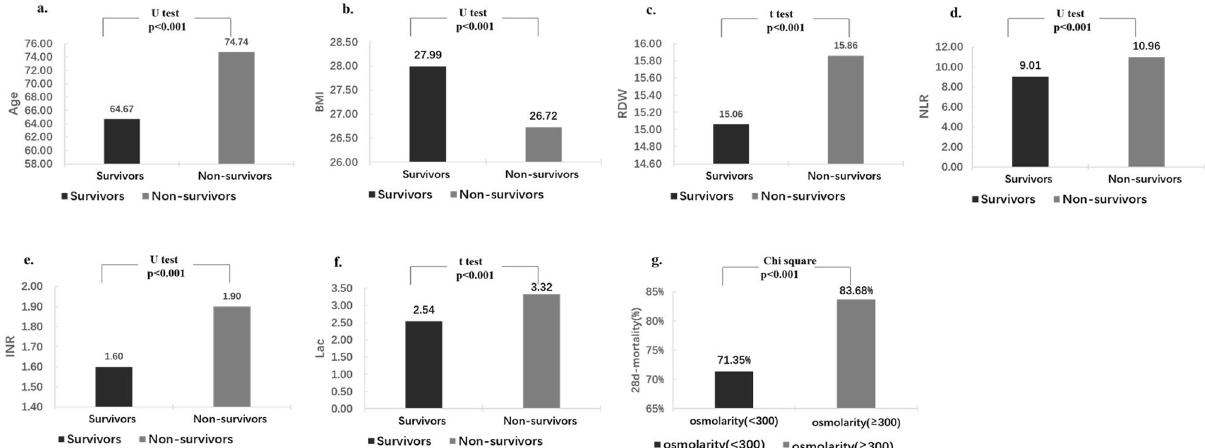
Figure 2. Comparisons of age, body mass index (BMI), red cell distribution width (RDW), neutrophil-to- lymphocyte ratio (NLR), international normalized ratio (INR), lactate (lac) concentration, and osmolarity between survivors and nonsurvivors in the development cohort. ( a ) Comparison of age by the U test, p < 0.001; ( b ) comparison of BMI by the U test, p < 0.001; ( c ) comparison of RDW by the t test, p < 0.001; ( d ) comparison of NLR by the U test, p < 0.001; ( e ) comparison of INR by the U test, p < 0.001; ( f ) comparison of lac concentration by the t test, p < 0.001; and ( g ) comparison of osmolarity by the chi-squared test, p < 0.001.